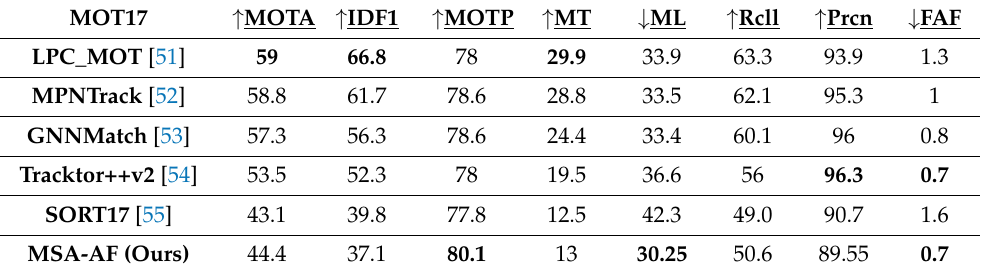
Table 4. Performance comparison with five state-of-the-art algorithms on MOT17.